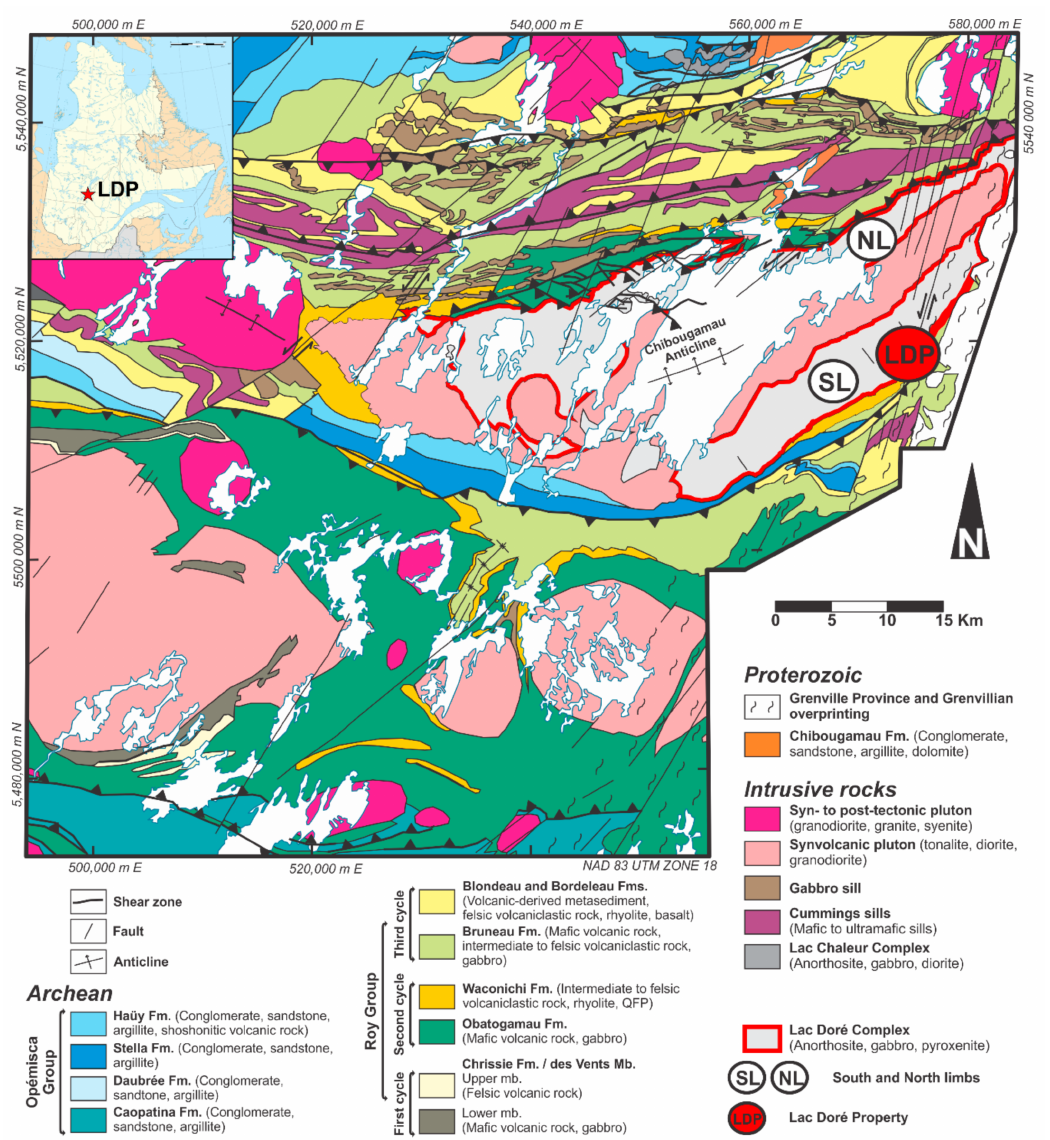
Figure 1. Simplified geological map of the Chapais-Chibougamau area showing the distribution of the Lac Dor é Complex (light grey) and the location of the Lac Dor é property (LDP). NL, North limb; SL, South limb. Modified after Leclerc et al.